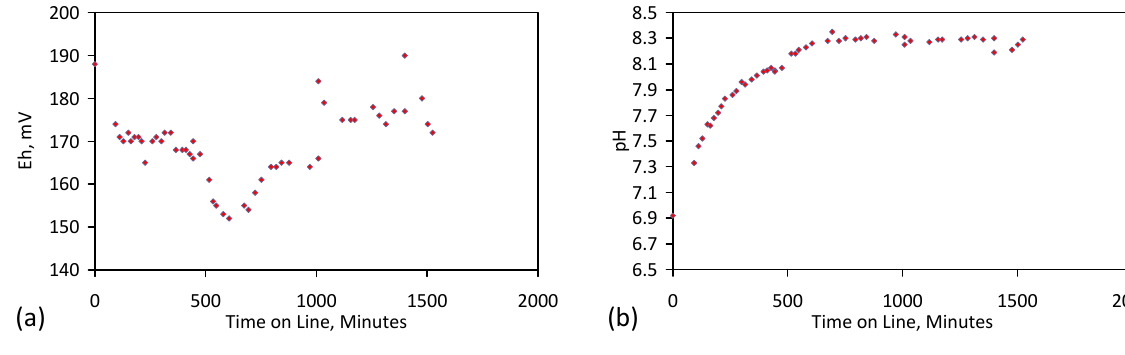
Figure C21. ZVM TPA example Trial E146. 1st Reuse; Operating Temperature: 15–20 °C; Oxidising Environment: Water volume in the reactor = 0.24 m 3 ; ZVM TPA from Trial E145 in a cartridge = 0.4 kg; Air flow = 120 L·h − 1 ; ( a ) Eh vs. time; ( b ) pH vs. time; ( c ) pH vs. Eh; ( d ) Salinity vs. time; ( e ) Salinity calculated from normalised data vs. salinity calculated from raw data; ( f ) EC vs.